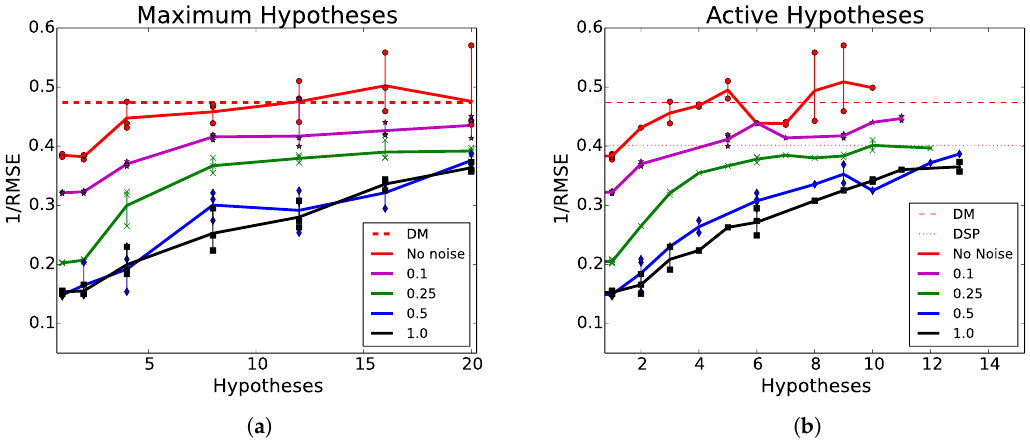
Figure 4. Inverse root mean-squared pixel error (RMSE) (higher is better) for noise conditions 0, 0.1, 0.25, 0.5, and 1 produced by MHDE networks. ( a ) presents results as a function of maximum hypotheses for networks trained with 1, 2, 4, 8, 12, 16, and 20 hypotheses. ( b ) presents the same results as ( a ) but instead plotted as a function of active